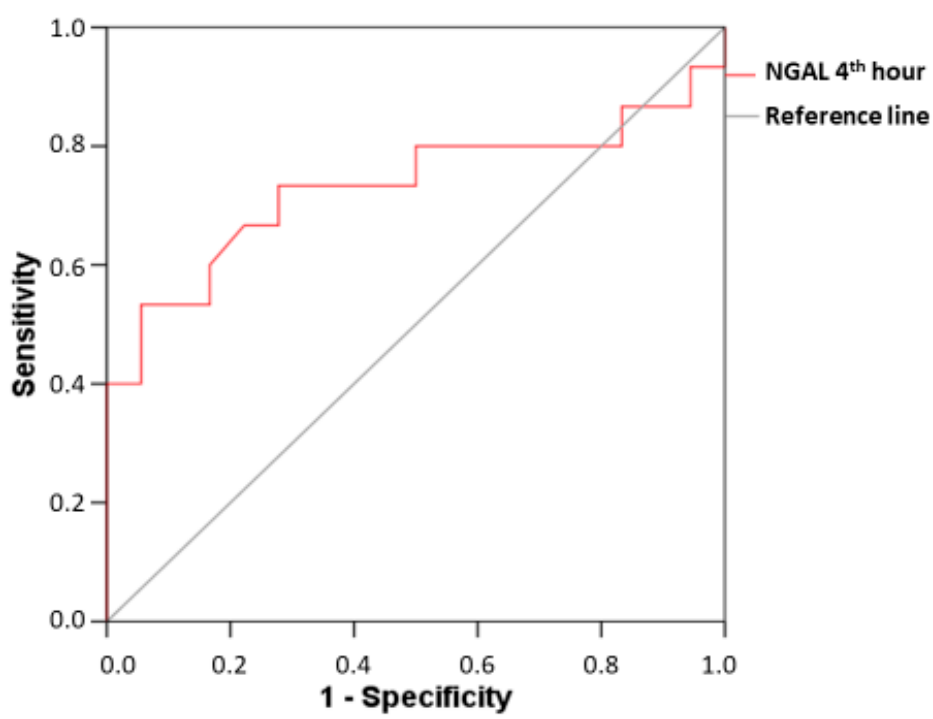
Figure 4. ROC curves for the diagnostic ability of plasma NGAL, measured at the 4th and 24th hour after the angiographic examination in the CI-AKI group.